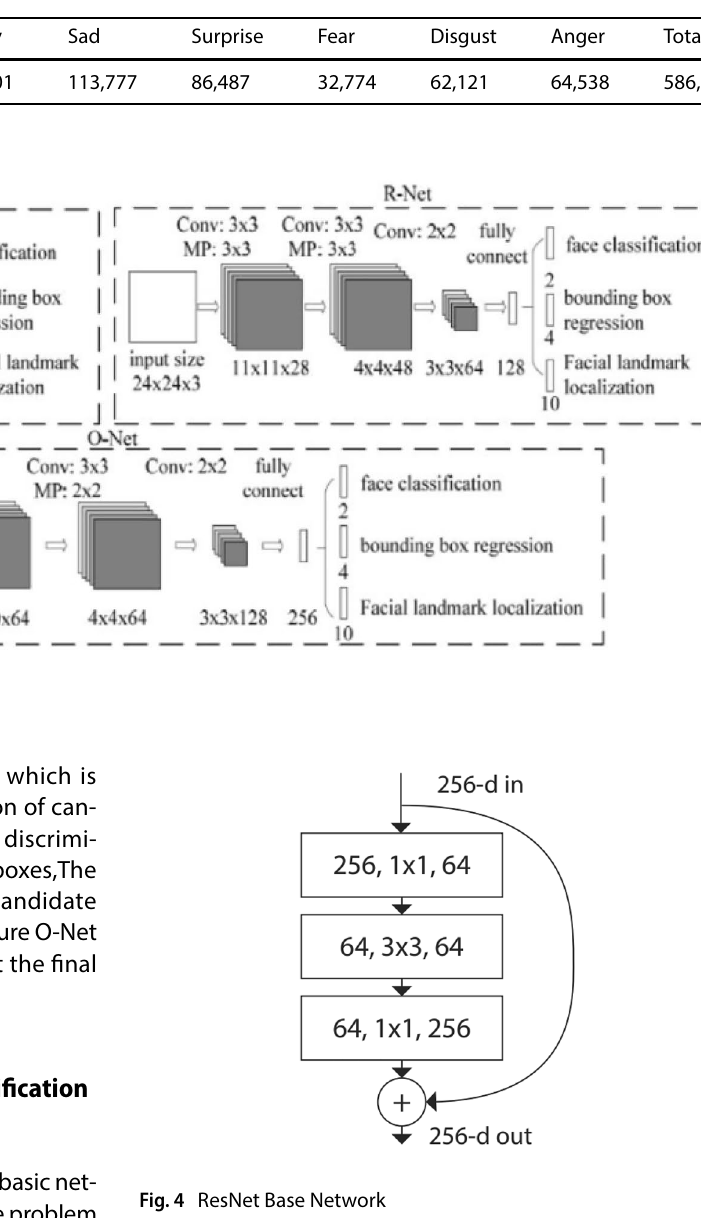
Fig. 4 ResNet Base